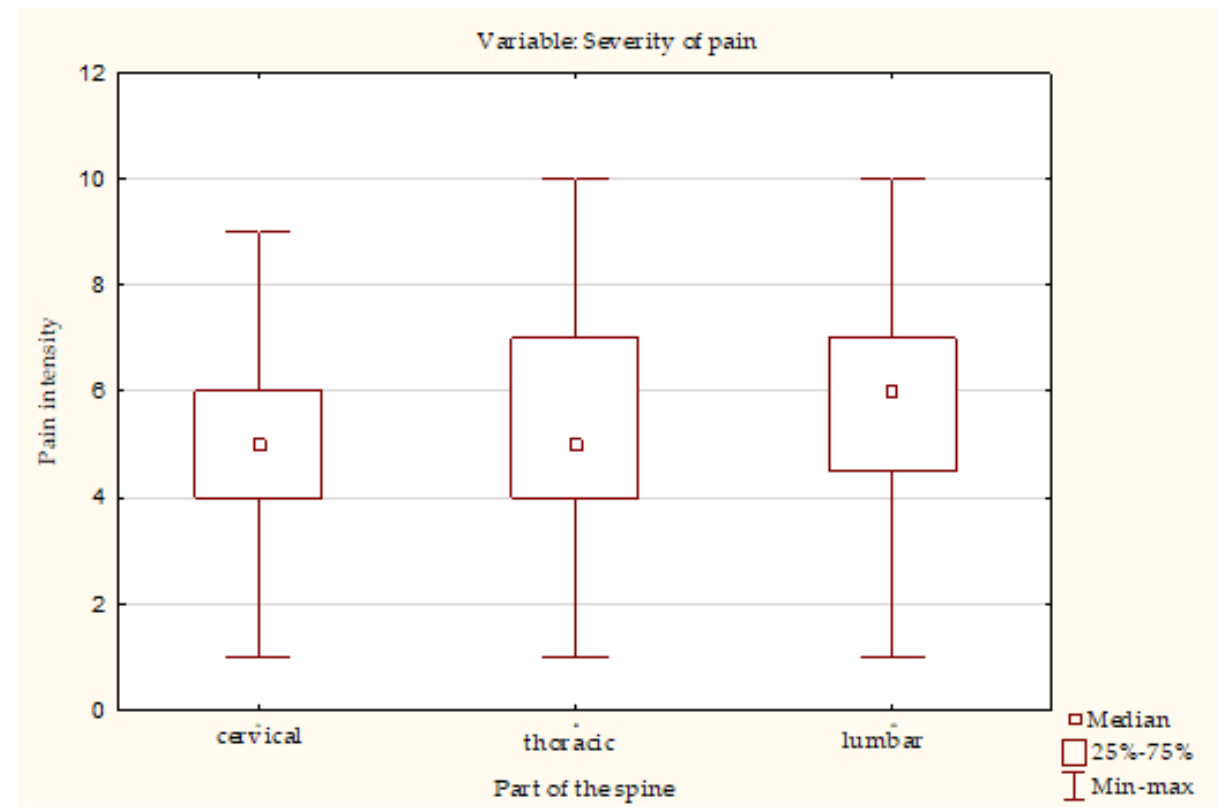
Figure 2. Difference in pain intensity in certain spine section.